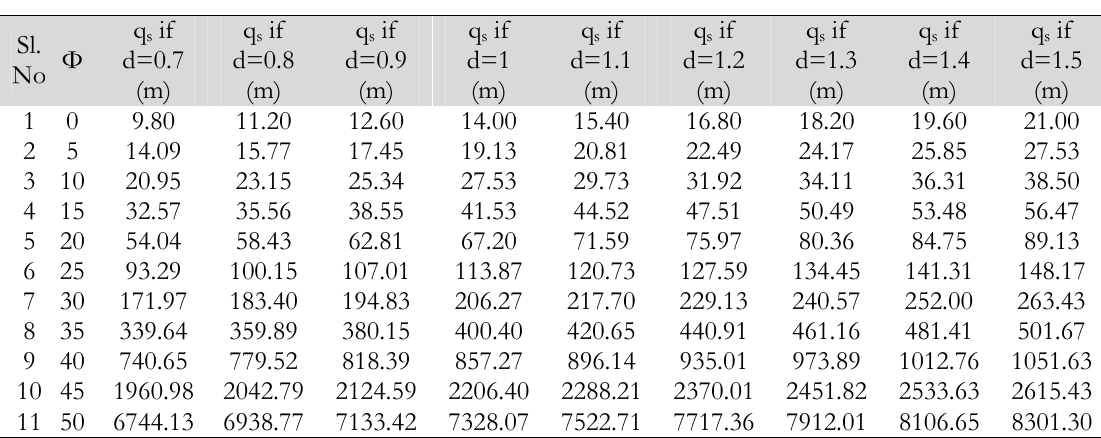
Table 3: Safe bearing capacity of soil when depth of foundation (d) is varied, cohesion is zero, width of foundation is 2.5 m and soil density (  ) is 14 kN/m 3 .